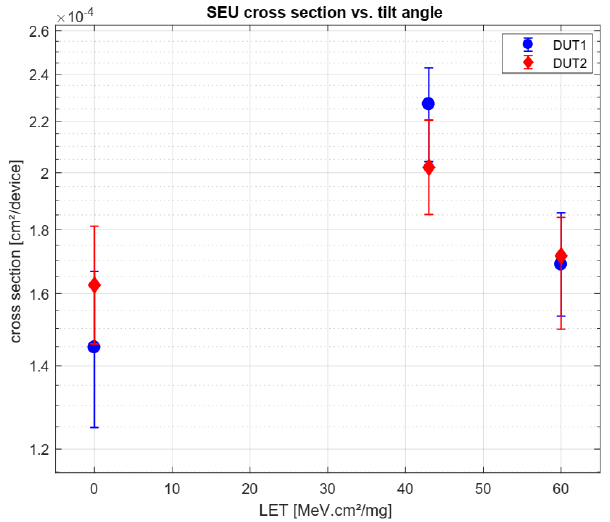
Figure 20. Tilt angle dependency for ( a ) SEUs on DUT 1 and DUT 2 at a LET of 62.5 MeV.cm²/mg with Xe on 0°, Rh on 43°, and Cr on 60° tilt angle.